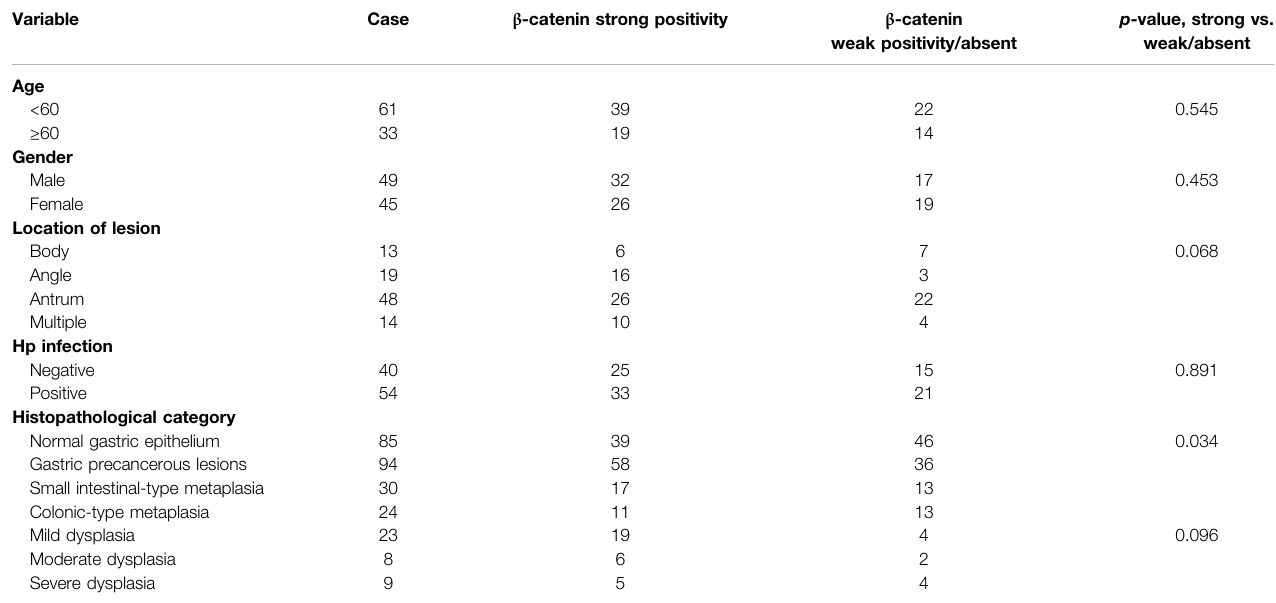
TABLE 2 | Correlation between β -catenin positivity and clinicopathological characteristics of patients with gastric precancerous lesions. Variable Case p -value, strong vs.